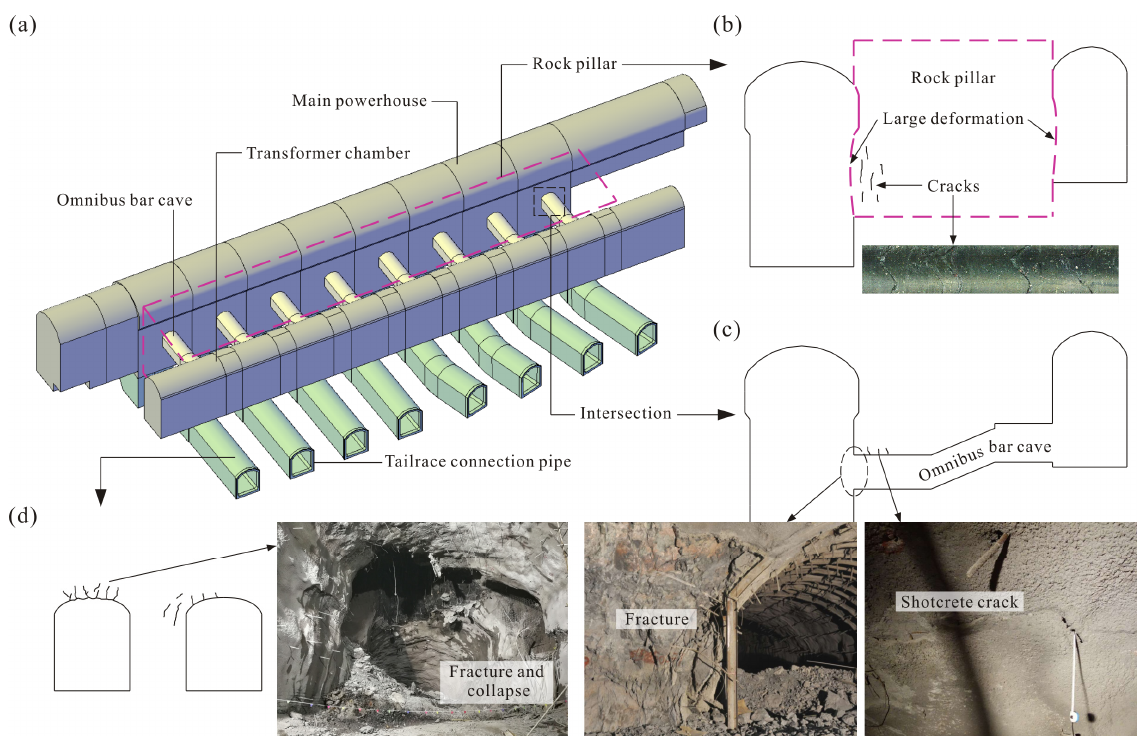
Figure 1. Deformation and failure of surrounding rock mass induced by the multi-cavern effect: ( a ) a large-scale underground powerhouse, ( b ) deformation and failure between the main powerhouse and transformer chamber (type LL), ( c ) between the main powerhouse and omnibus bar cave (type LS) and ( d ) between tailrace connection pipes (type SS).